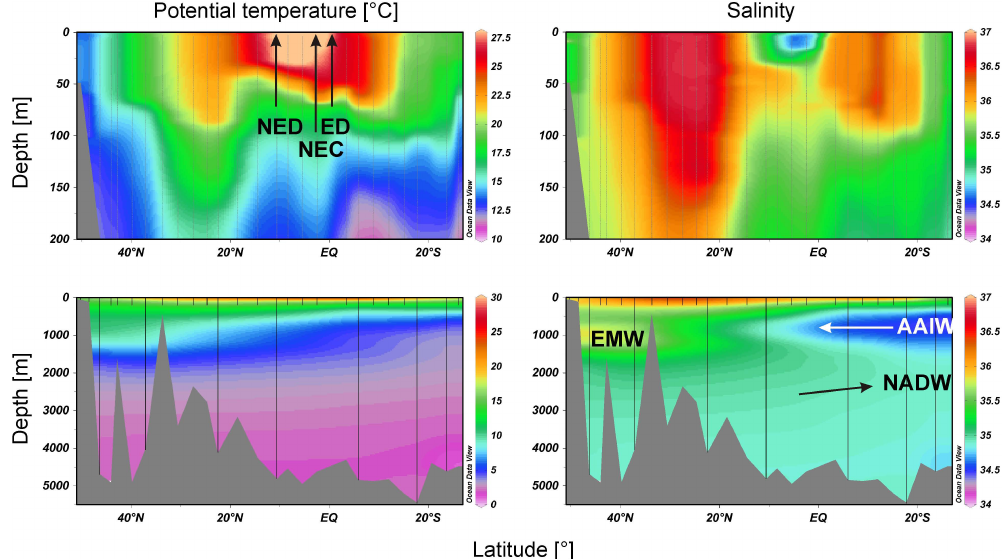
Fig. 2. Potential temperature (temperature at standard reference pressure) and salinity for two different depth intervals: euphotic zone (upper 200 m; upper two graphs) and total water column (lower two graphs). Main deep water masses were Eurafrican Mediterranean Water (EMW), Antarctic Intermediate Water (AAIW) and North Atlantic Deep Water (NADW). Within the inner-tropical convergence zone, the North Equatorial Divergence (NED), North Equatorial Convergence (NEC) and Equatorial Divergence (ED) are